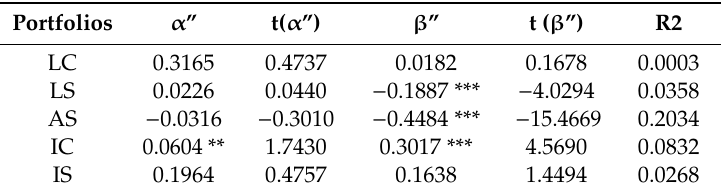
Table 6. Performance